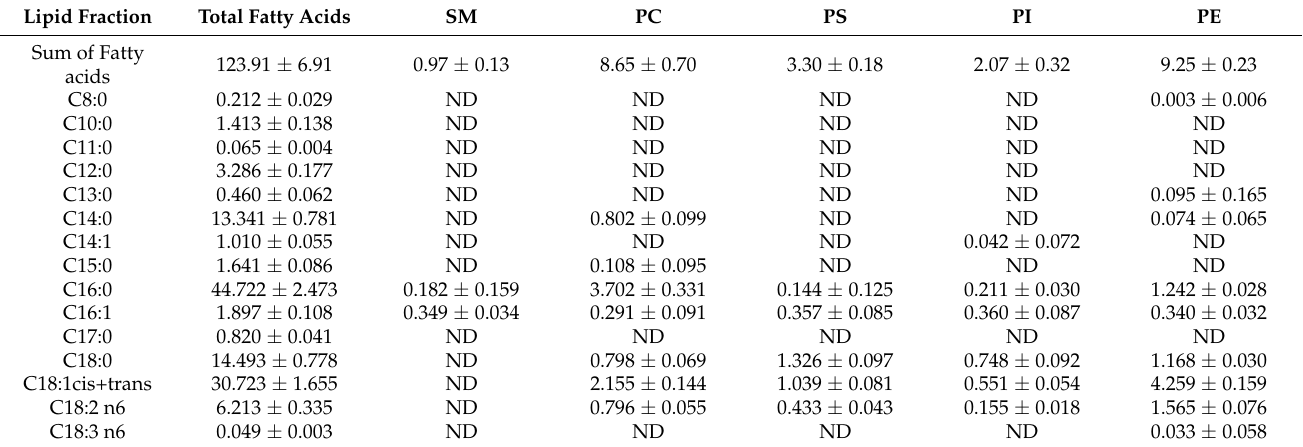
Figure 9. Pie charts listing the percentage distribution of ( a ) free vs. calculated esterified oxylipins (i.e., the difference between total and free oxylipins), ( b ) free oxylipins, ( c ) total oxylipins, and ( d ) calculated esterified oxylipins derived from various fatty acid precursors, including from linoleic acid (LNA), dihomo-gamma-linolenic (DGLA), arachidonic acid (ARA), α -linolenic acid (ALA), eicosapentaenoic acid (EPA), and docosahexaenoic acid (DHA). Table 3. Fatty acid amount per lipid fraction (mg/g) in sample